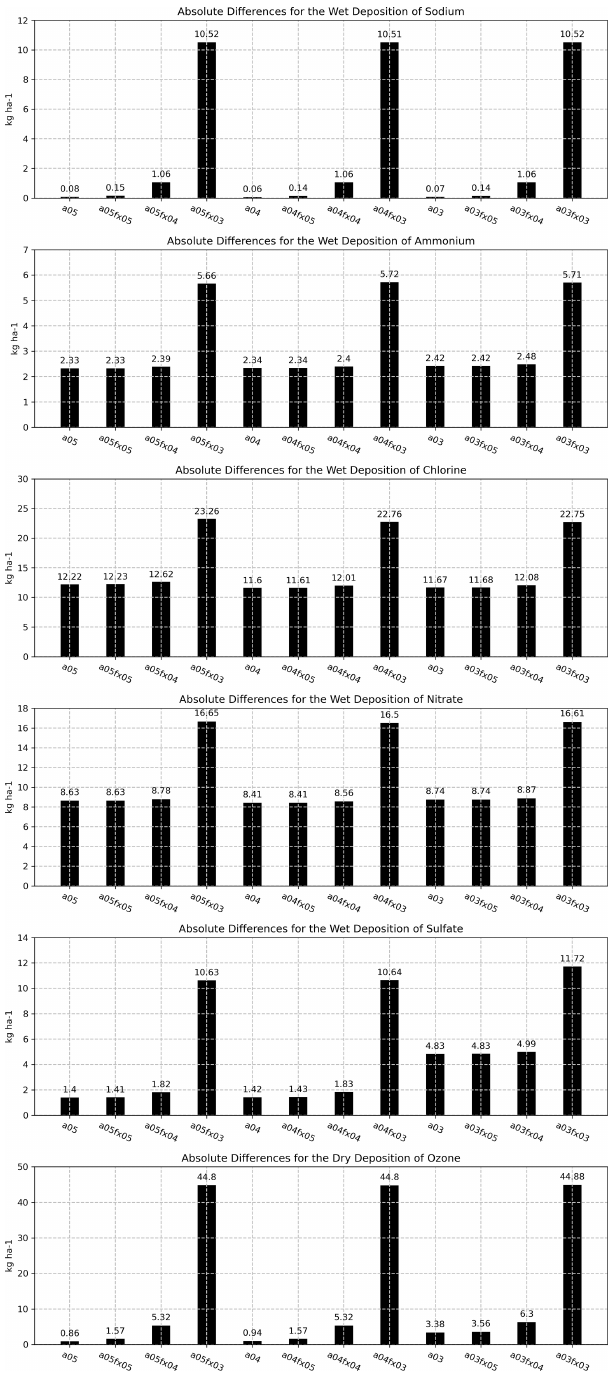
Figure 10. Total absolute bias difference between the orig simula- tion and the altered cases and simulations by deposition rate (row) throughout 2016 utilizing hourly